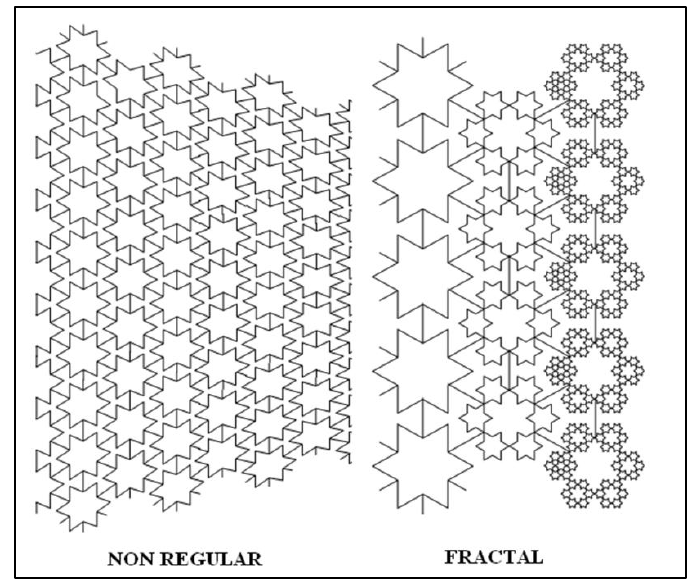
Figure 17. Dimensional variation of auxetic structure n.2 in a non-regular system or in a fractal